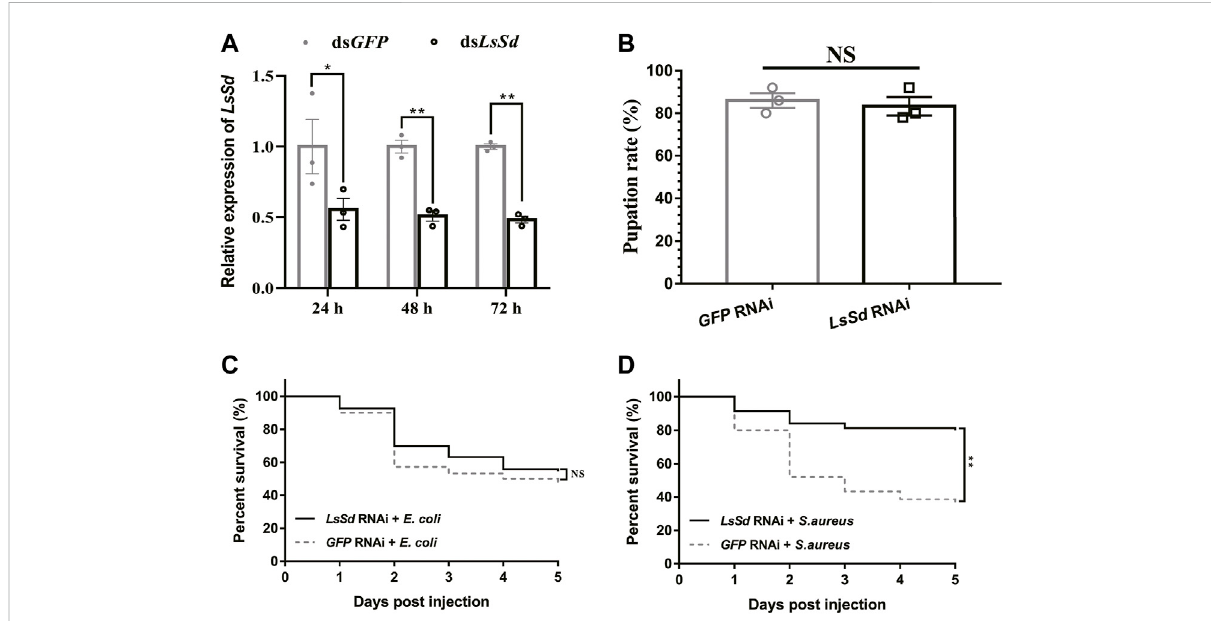
FIGURE 5 Susceptibility of L. serricorne larvae against E. coli and S. aureus infections after knockdown of LsSd . (A) RNAi ef fi ciency of the LsSd gene was detected at 24, 48, and 72 h after dsRNA treatment in L. serricorne larvae. (B) Effect of LsSd RNAi on L. serricorne pupation rate. (C) E. coli and (D) S. aureus were inoculated at 24 h post LsSd RNAi, and larval survival was recorded daily for 5 days in each treatment group. Error bars indicate the SEM of three independent biological replications. Statistical analysis of survival analysis was carried out based on Kaplan-Meier method (Log-rank Chi-square test; ** p <